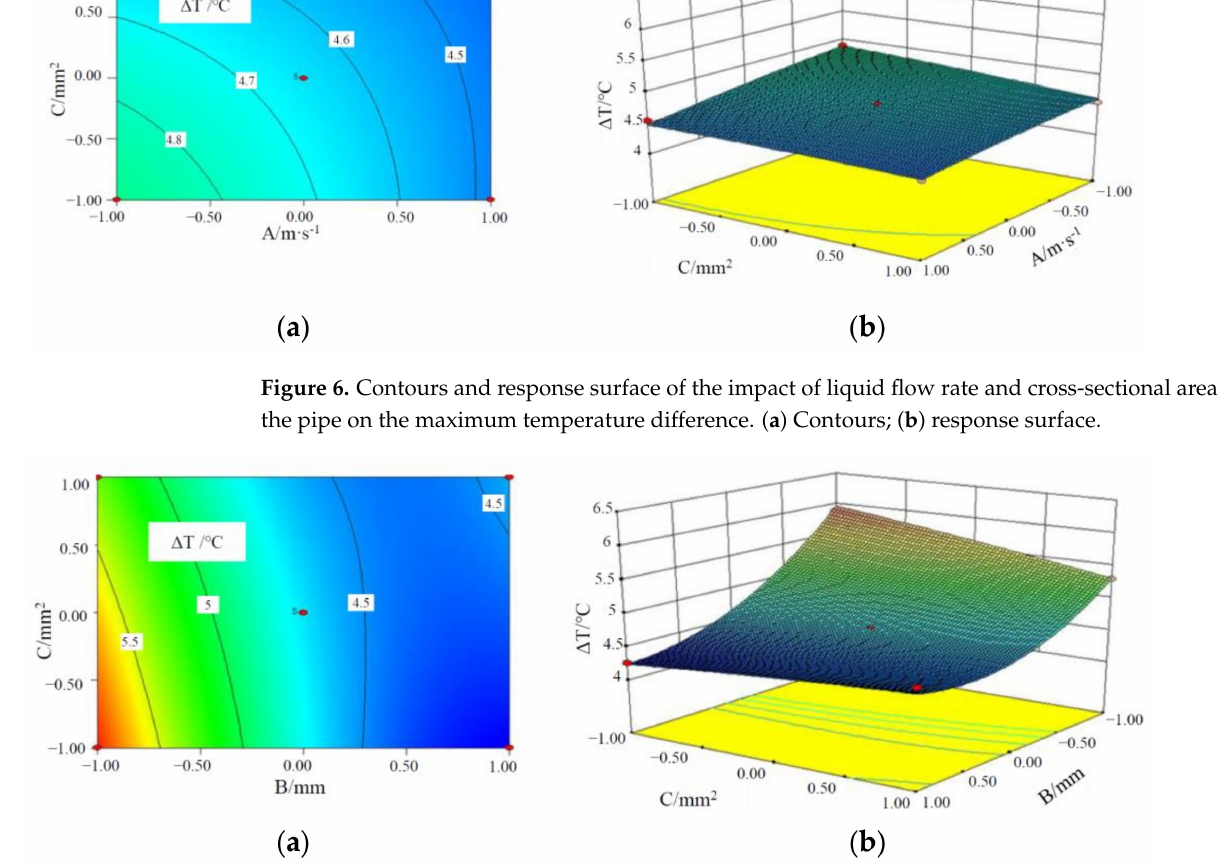
Figure 7. Contours and response surface of the impact of CPCM thickness and cross-sectional area of the pipe on the maximum temperature. ( a ) Contours; ( b ) response